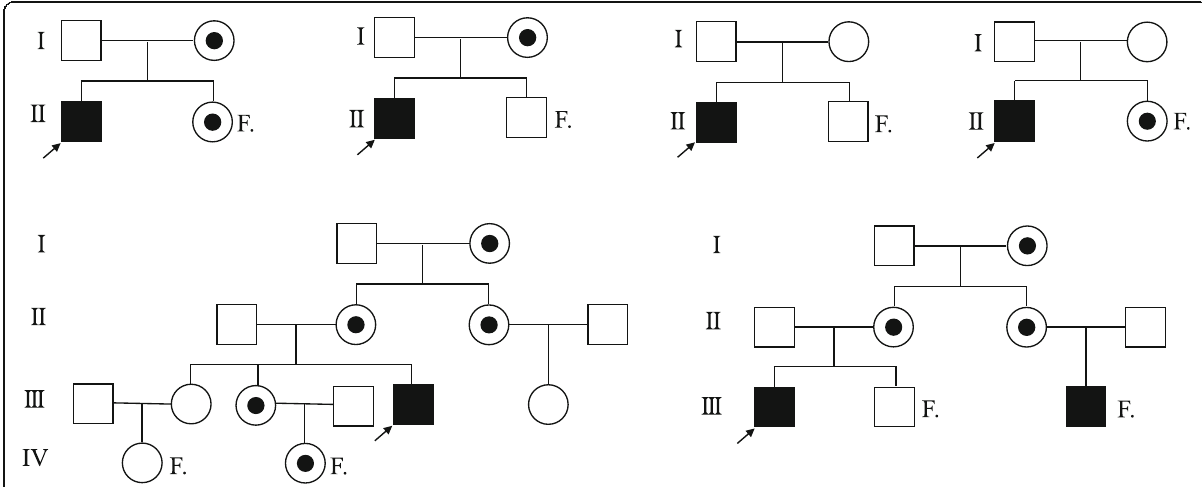
Fig. 3 The pedigree patterns of DMD families. ■ and the arrowhead mean the proband of the family. ☉ means the carrier in the family. F. means the